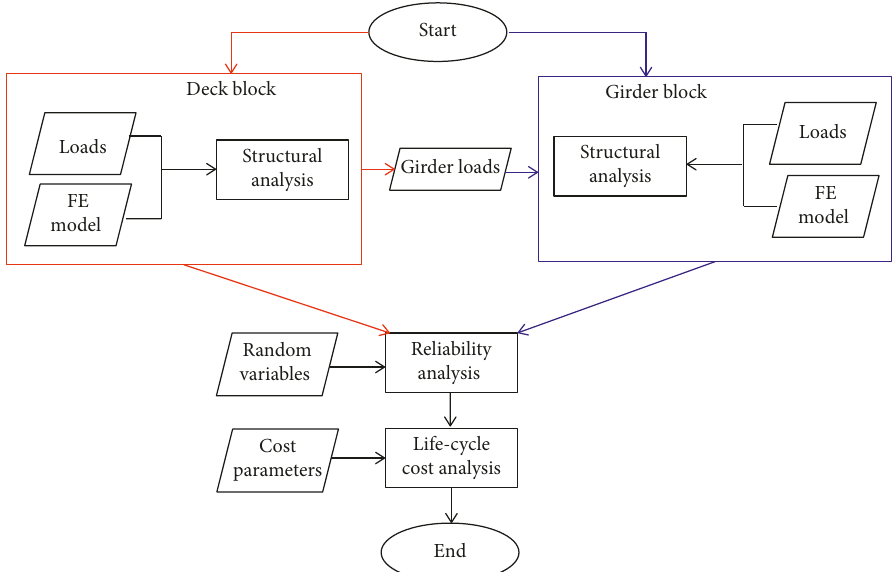
Figure 1: Outline of the proposed automated